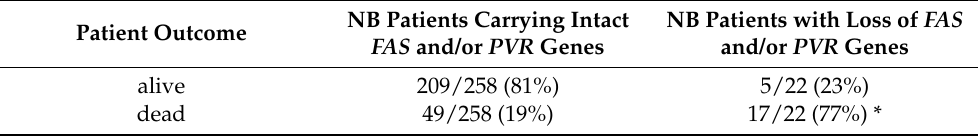
Table 3. Association between FAS and/or PVR gene loss and fatal outcome in NB